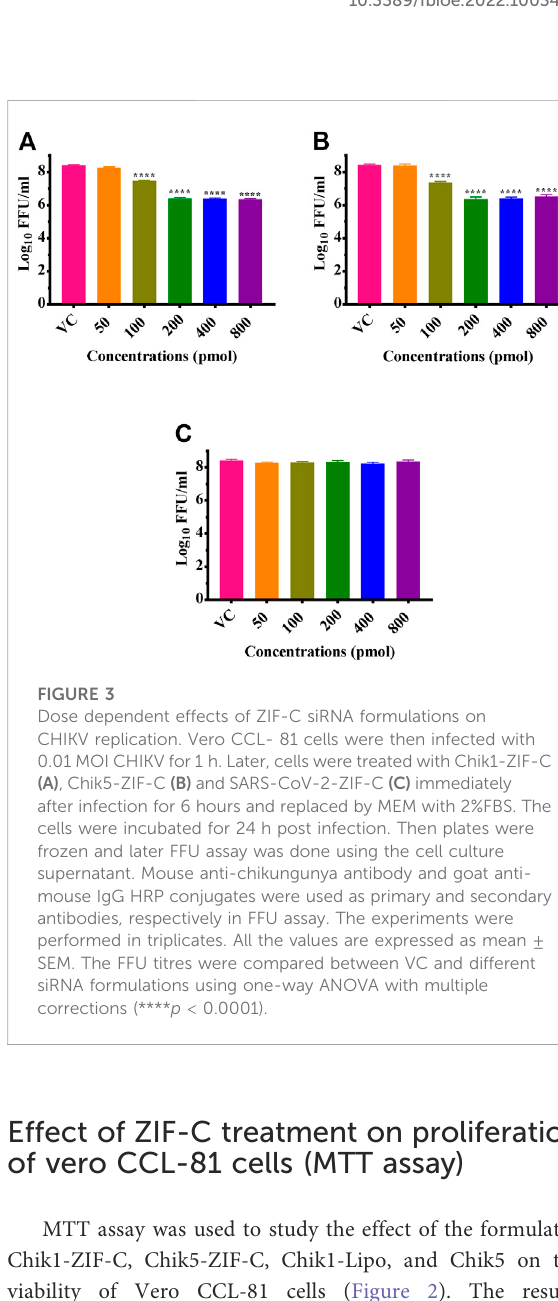
(Figure 1E). Microwave Plasma Atomic Emission